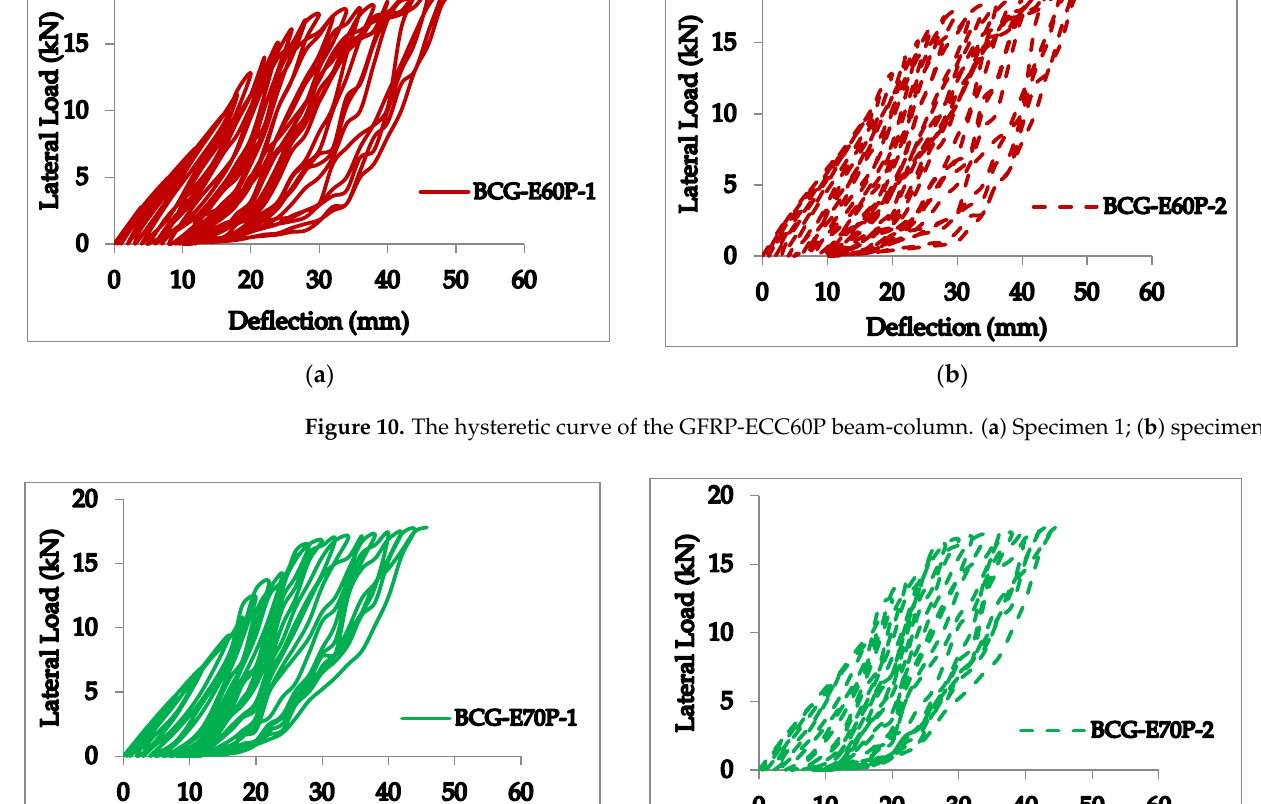
( b ) Figure 12. The hysteretic curve of the GFRP-ECC80P beam-column. ( a ) Specimen 1; ( b ) specimen 2. 3.2. Strength of the Beam-Column Specimens Figure 13 depicts the cyclic envelope or P –Δ curves for the GFRP beam-column with or without HVFA-ECC. The lateral load capacity of the specimens is taken as the average of the load values when they were subjected to lateral loading in the forward direction. The BCG-H specimens attained an average ultimate lateral load of 13.6 kN with an aver- age lateral displacement of 30 mm. The BCG-E60P specimens recorded an average lateral peak load of 19.5 kN with an average lateral displacement of 51.2 mm. The BCG-E70P specimens exhibited an average ultimate lateral strength of 17.82 kN with an average lat- eral displacement of 45.8 mm. The average lateral ultimate load of the BCG-E80P speci- mens was 16.35 kN with an average lateral displacement of 38.35 mm.